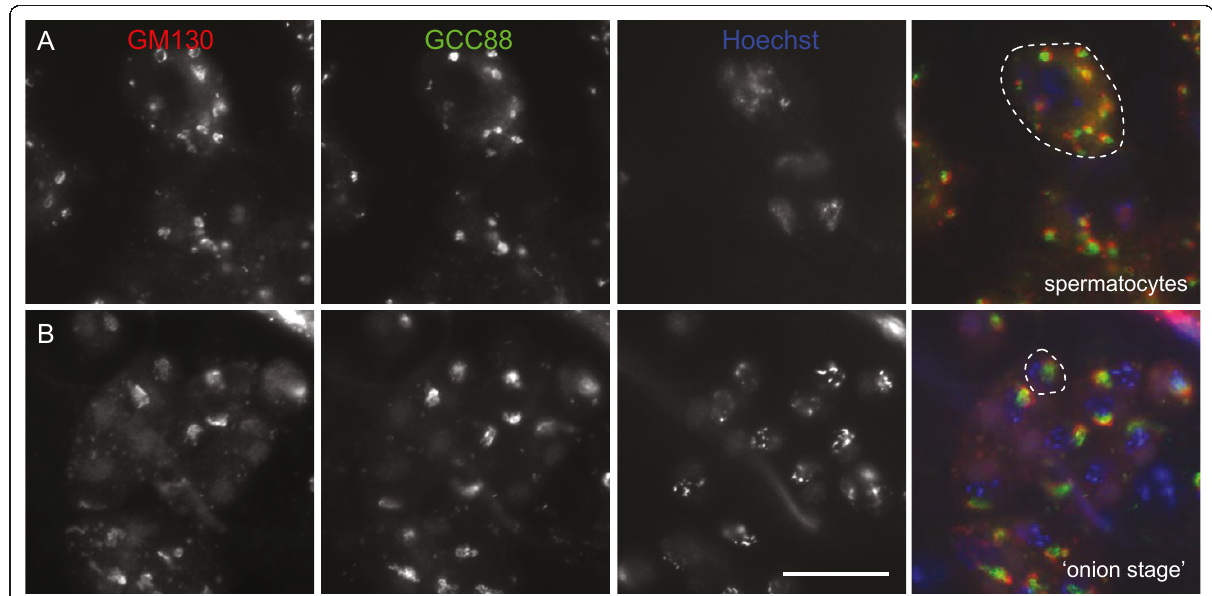
Figure 4 Co staining of Golgi markers GM130 and GCC88 in Drosophila testes . Testes squashes were triple labelled for GM130 (Golgi marker), GCC88 (TGN marker) and Hoechst (nuclei). Note the coincident labelling of GM130 and GCC88, seen most clearly in the large peripheral puncta in the spermatocytes (A) and the cone-shaped juxtanuclear acroblast in the ‘ onion stage ’ spermatids (B) . Note that the staining of GM130 is slightly off-set relative to GCC88 as we would expect since they are on opposed sides of the Golgi stack. Bar, 20 μ